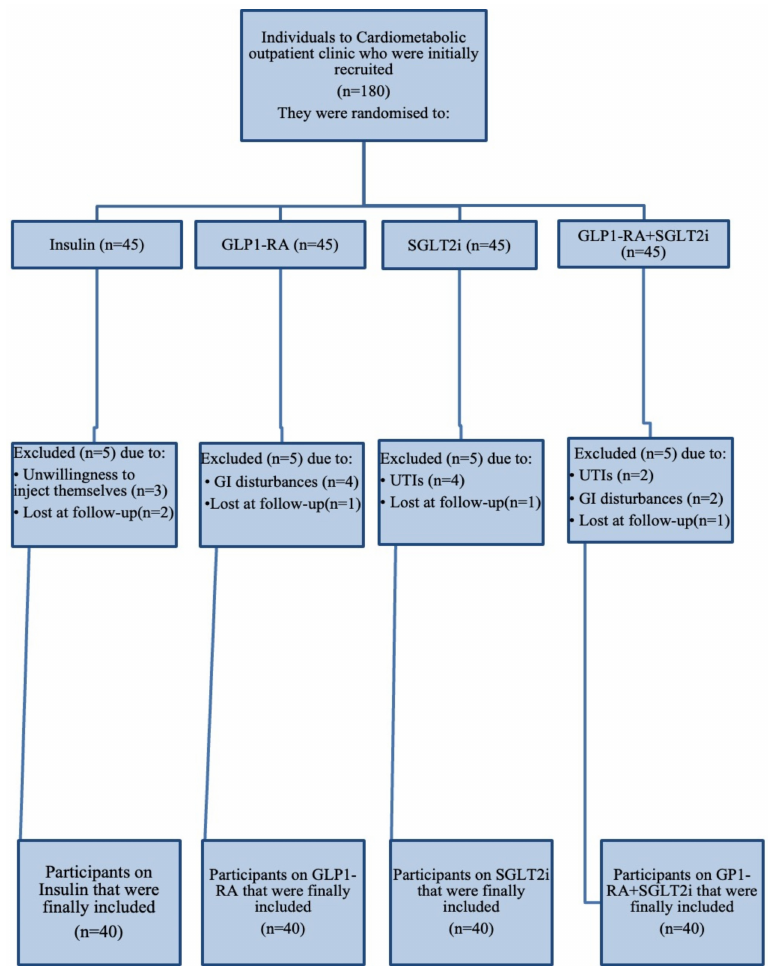
Figure 1. Flowchart of study progress. GLP-1RA: glucagon-like peptide-1 receptor agonists; SGLT-2i: sodium-glucose cotransporter-2